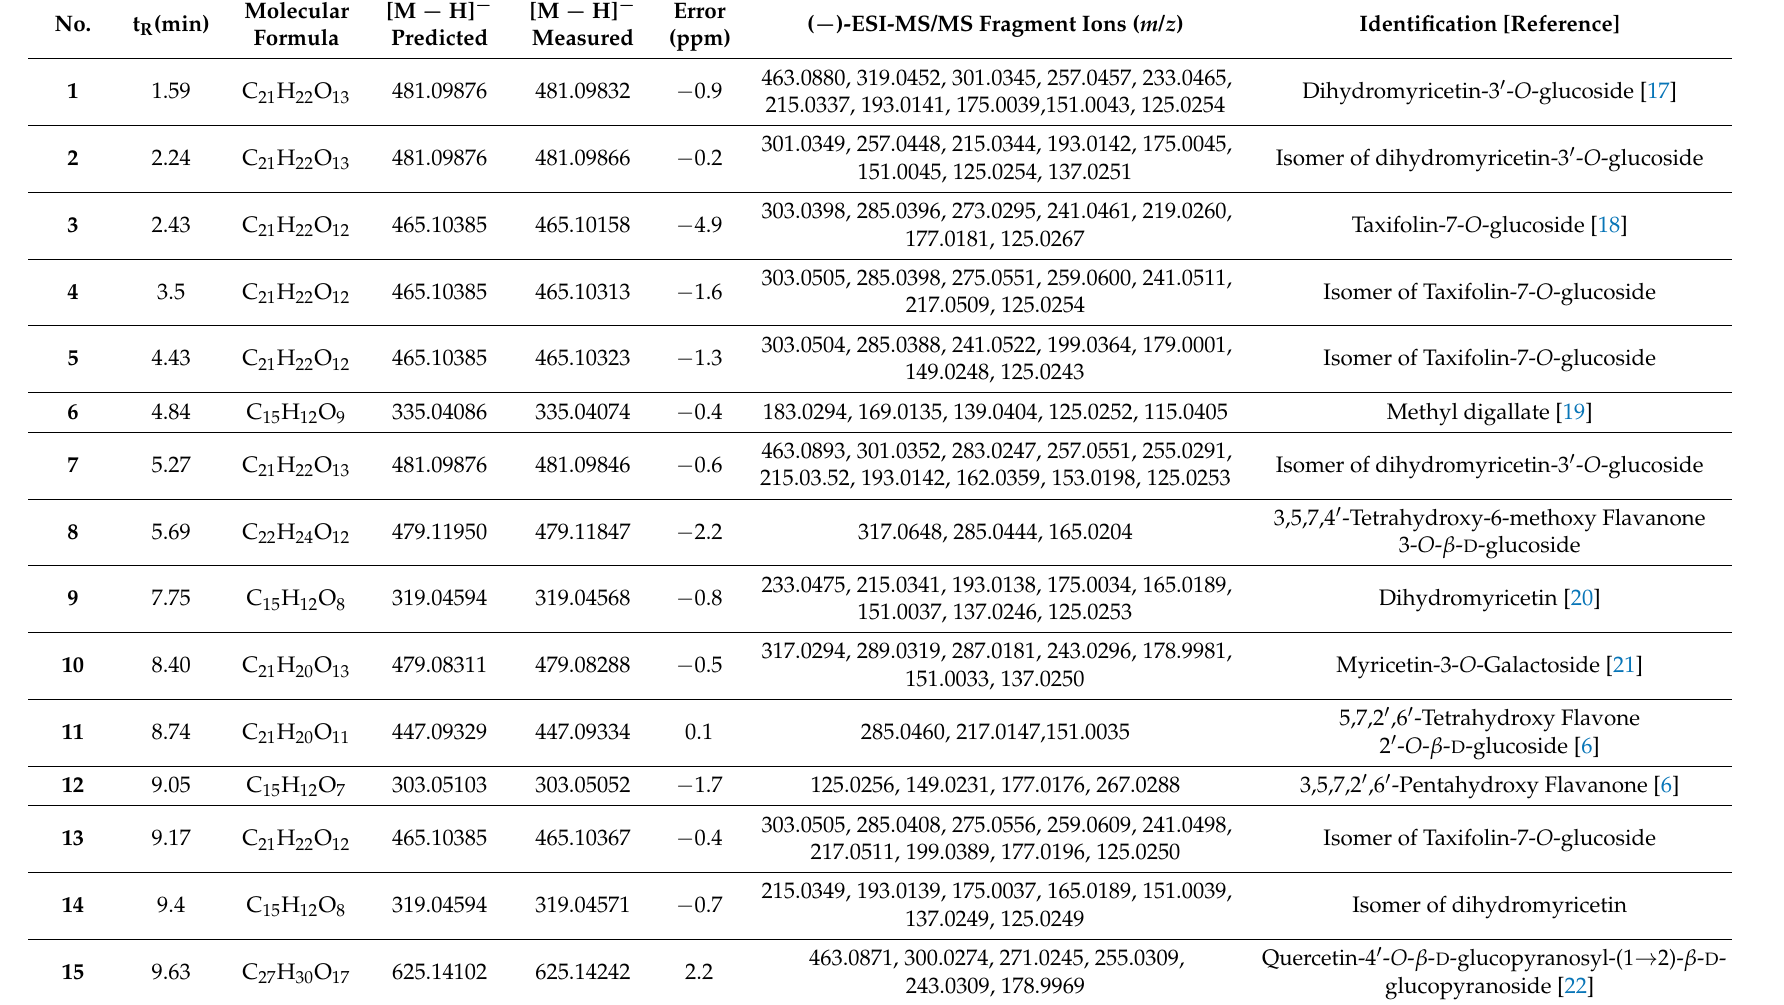
Table 1. Compounds identified by UHPLC-QTOF-MS/MS in S. baicalensis collected at different growth stages.